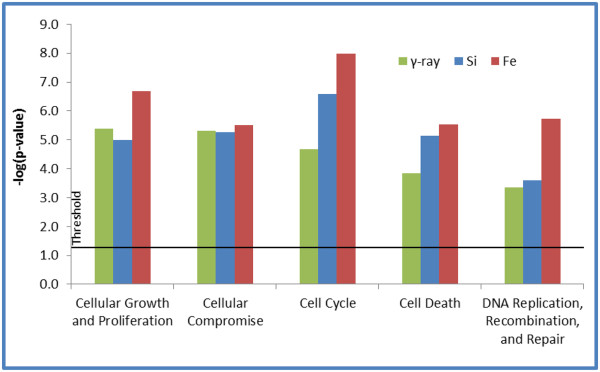
Gene function analysis for differentially expressed genes after radiation. Gene enrichment analysis using Ingenuity pathways Analysis software for identification of common gene function categories regardless of radiation type. The horizontal line denotes a significance level of (p<0.05).